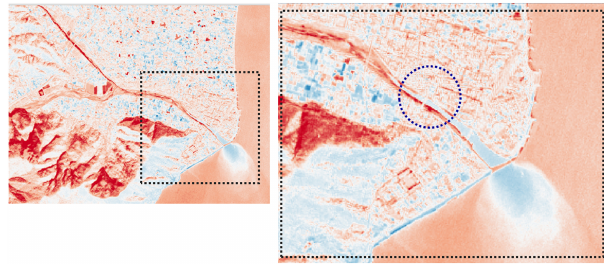
Figure 7. Mathematical difference of NDWI value over town of Albenga between dates 9 October and 28 November 2016. Image contains modified Copernicus Sentinel data